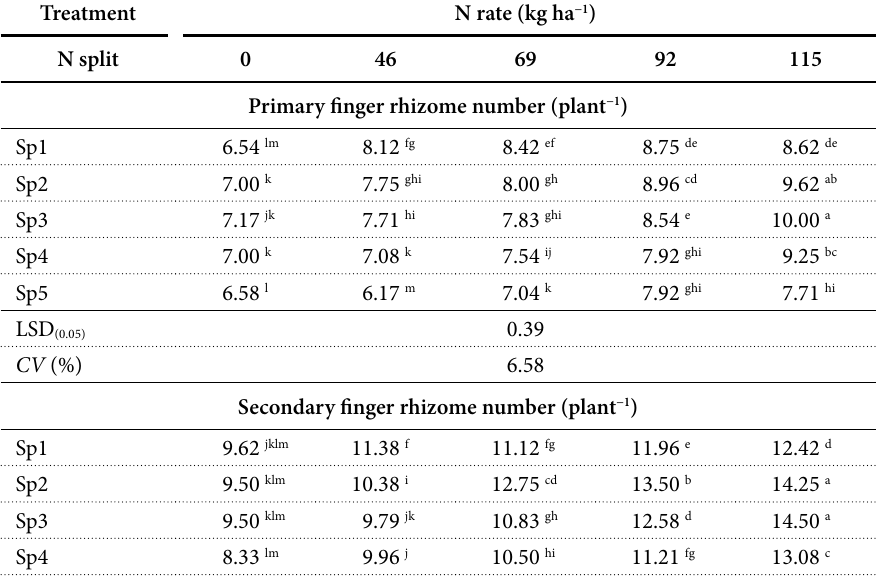
Tab. 5 Interaction effects of N rate and time of application on primary and secondary finger rhizome number per plant of Curcuma longa grown at Tepi, southwestern Ethiopia in 2016/2017. Treatment